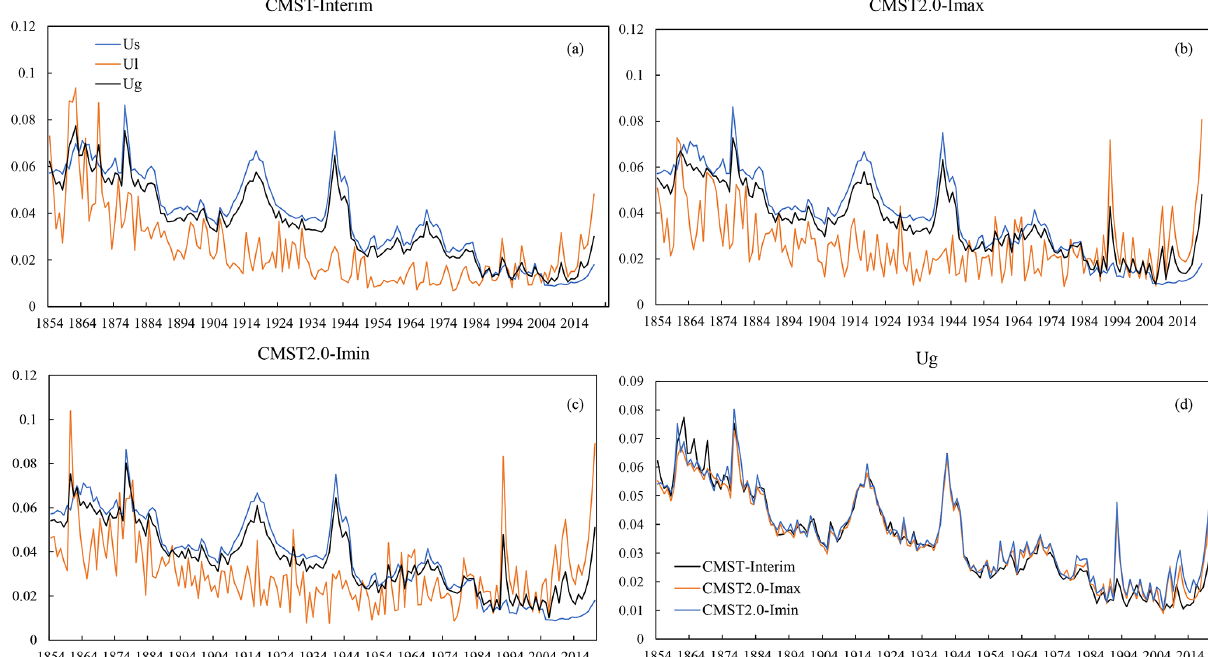
Figure 8. Uncertainties in GMST ( U g ), LSAT ( U l ), and SST ( U s ) for CMST-Interim (a) , CMST 2.0 − Imax (b) , and CMST 2.0 − Imin (c) and their comparison of U g (d)